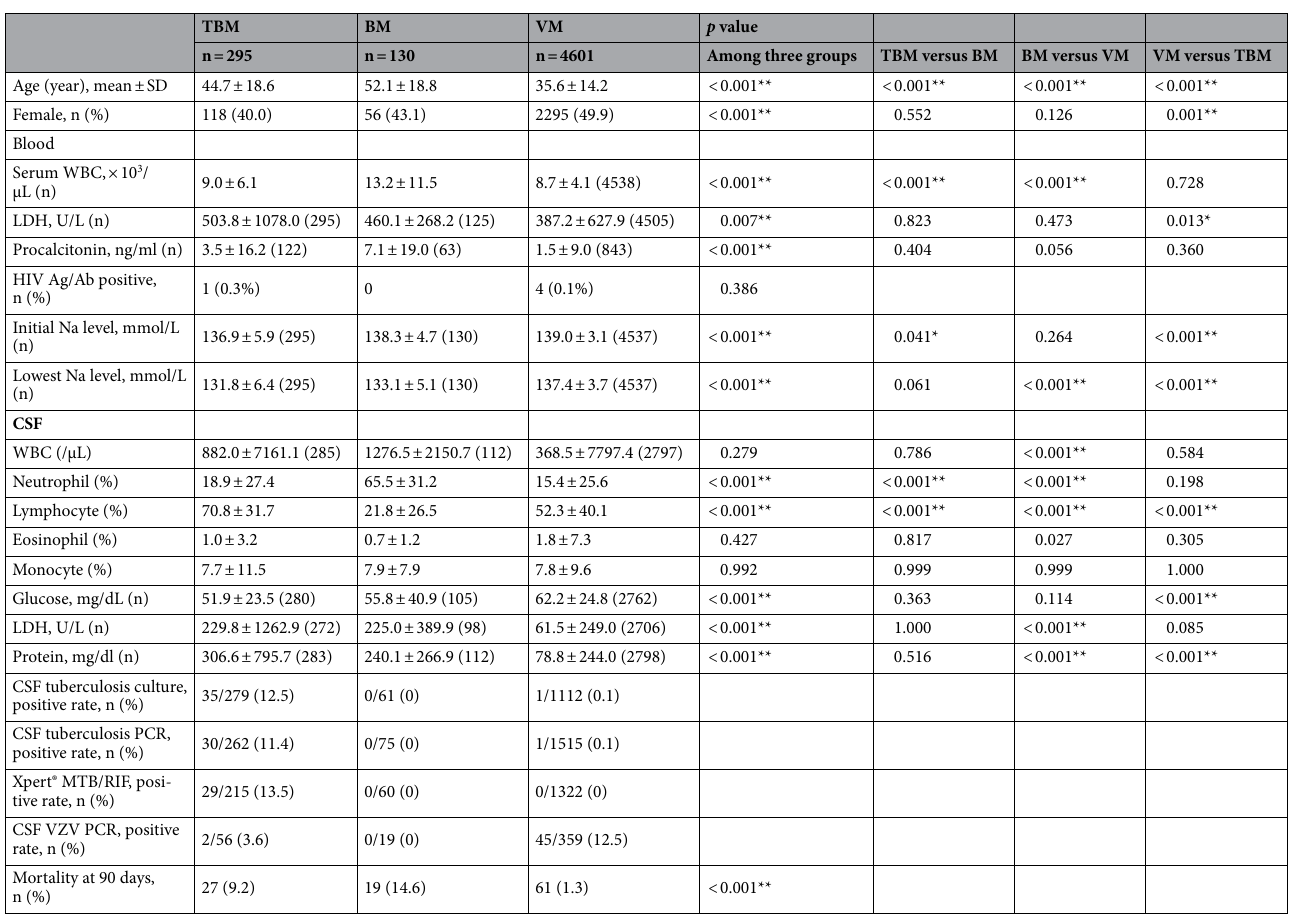
Table 1. Baseline clinical characteristics and laboratory findings in patients with tuberculosis, viral, and bacterial meningitis. BM, bacterial meningitis; CSF, cerebrospinal fluid; LDH, lactate dehydrogenase;